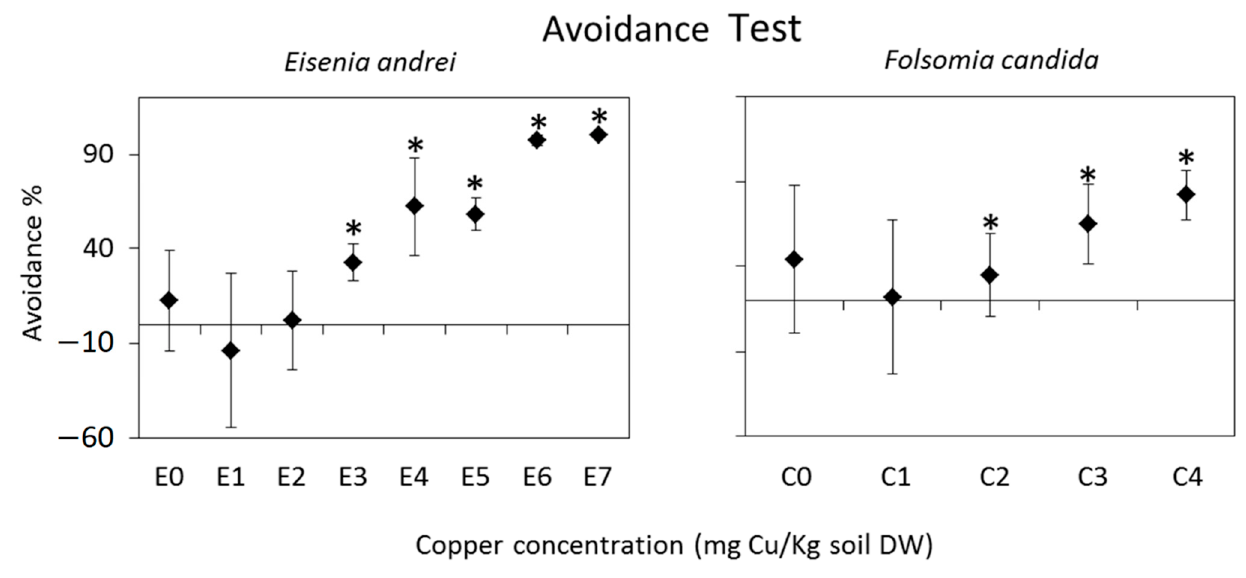
Figure 2. Avoidance tests with Eisenia andrei and Folsomia candida . Percentage of avoidance (average ± standard deviation; n = 5) in test units combining uncontaminated soil with a copper contaminated soil. * indicates significant avoidance response ( p ≤ 0.05) after Fisher exact test. Table 3. Avoidance concentrations (AC x ; with corresponding 95% confidence intervals) estimated for Eisenia andrei and Folsomia candida exposed to concentration gradients of copper spiked soil. AC x values are expressed in mg of Cu per kg of soil (dry weight equivalent).